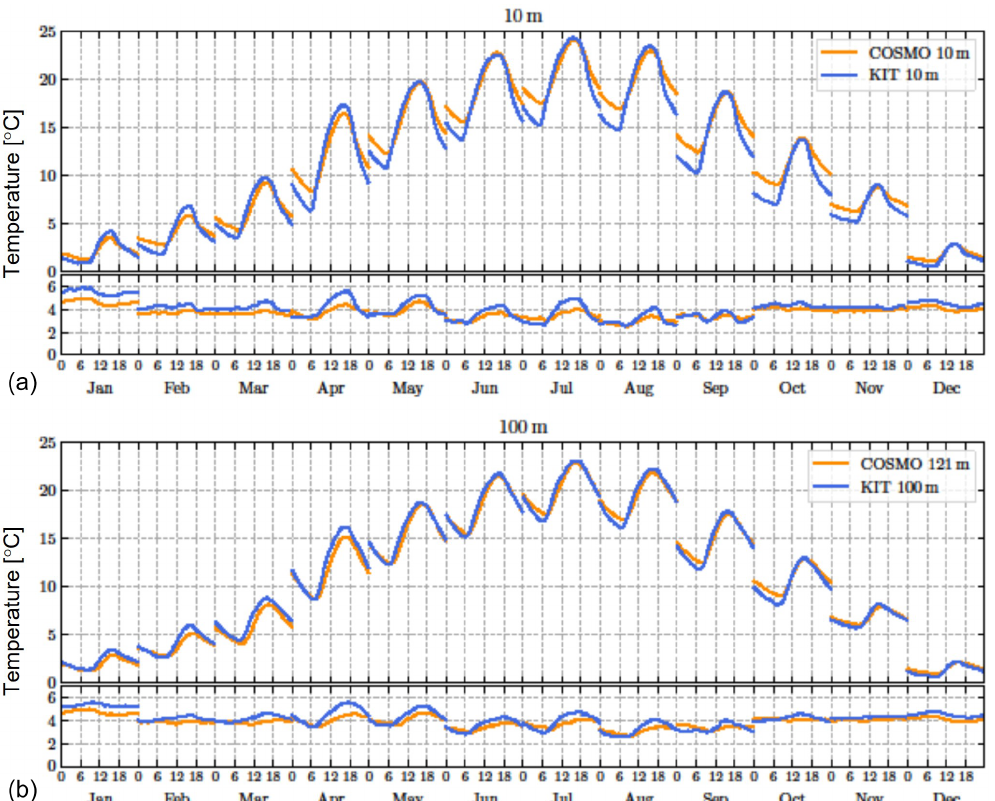
Figure 7. Monthly mean diurnal cycles (local time) and respective standard deviation (see text) for air temperature ( ◦ C) in 10m (a) and 100m (b) height at the KIT tower and for the COSMO grid boxes around the KIT location.